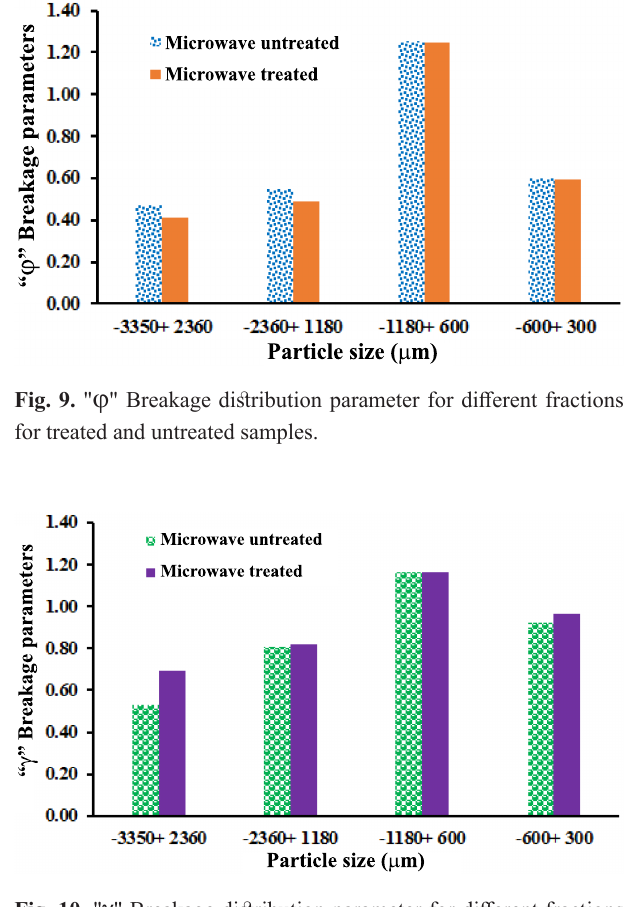
Fig. 10. " γ " Breakage distribution parameter for different fractions for treated and untreated samples.